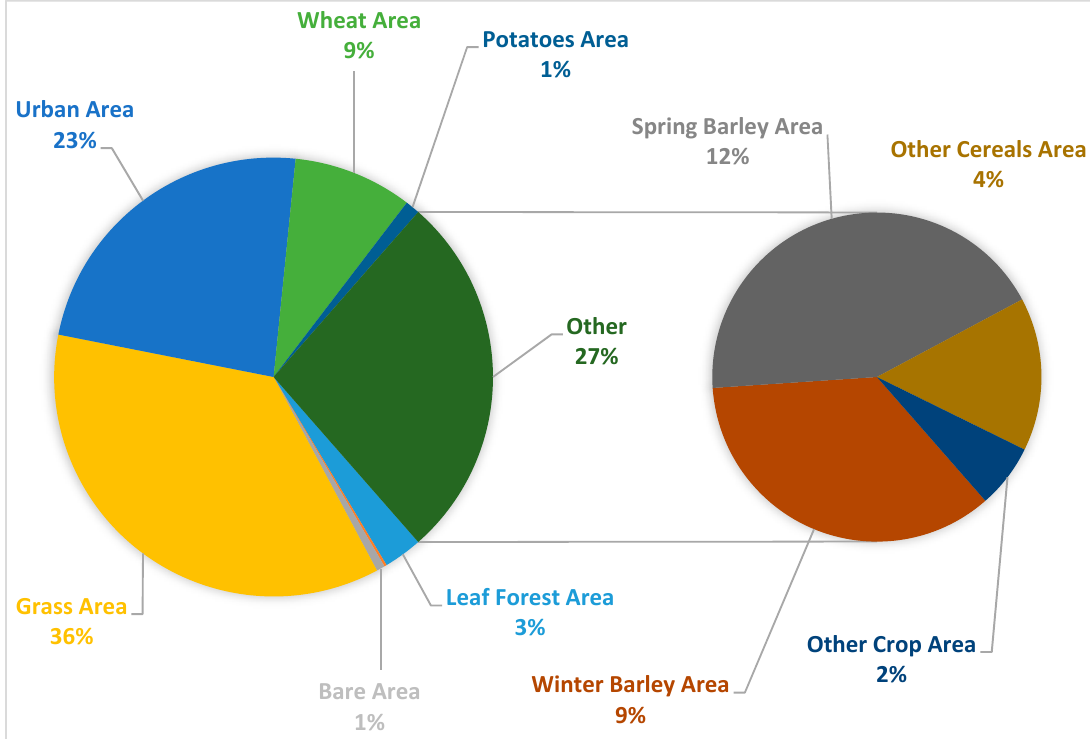
Figure 3. Detailed land use in the Frome catchment.